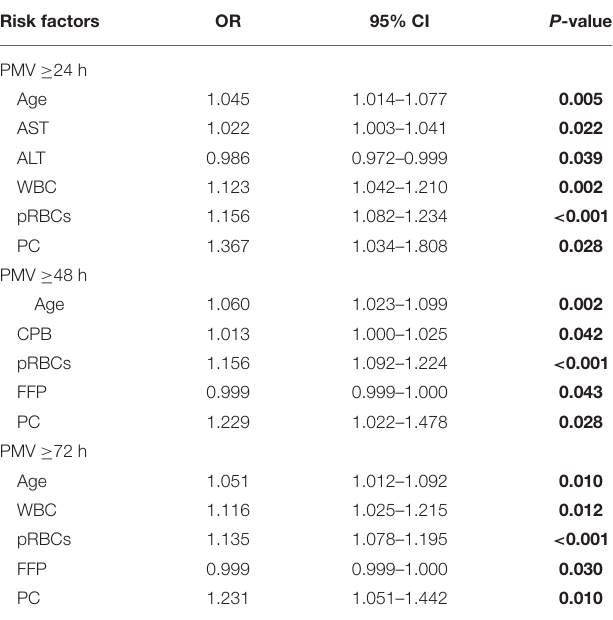
TABLE 5 | Multivariate analysis for three PMV